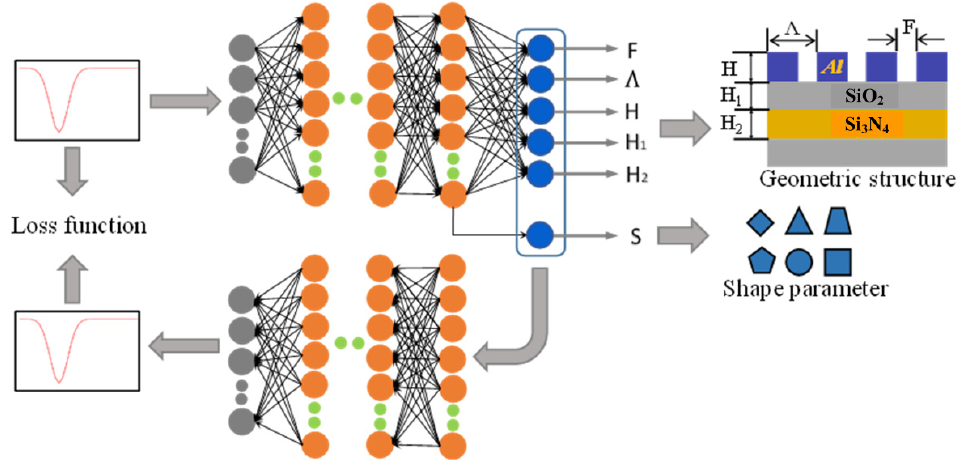
Figure 6. Schematic diagram of the series feedback neural network.